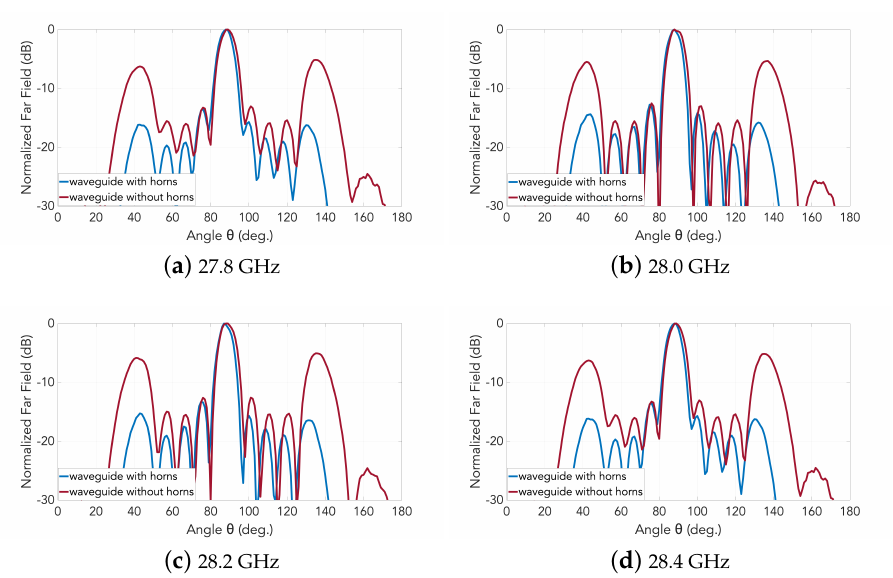
Figure 16. Measured normalized radiation patterns in H-plane of the 2D transverse waveguide slot array with and without horns: ( a ) 27.8 GHz; ( b ) 28.0 GHz; ( c ) 28.2 GHz; and ( d ) 28.4 GHz.